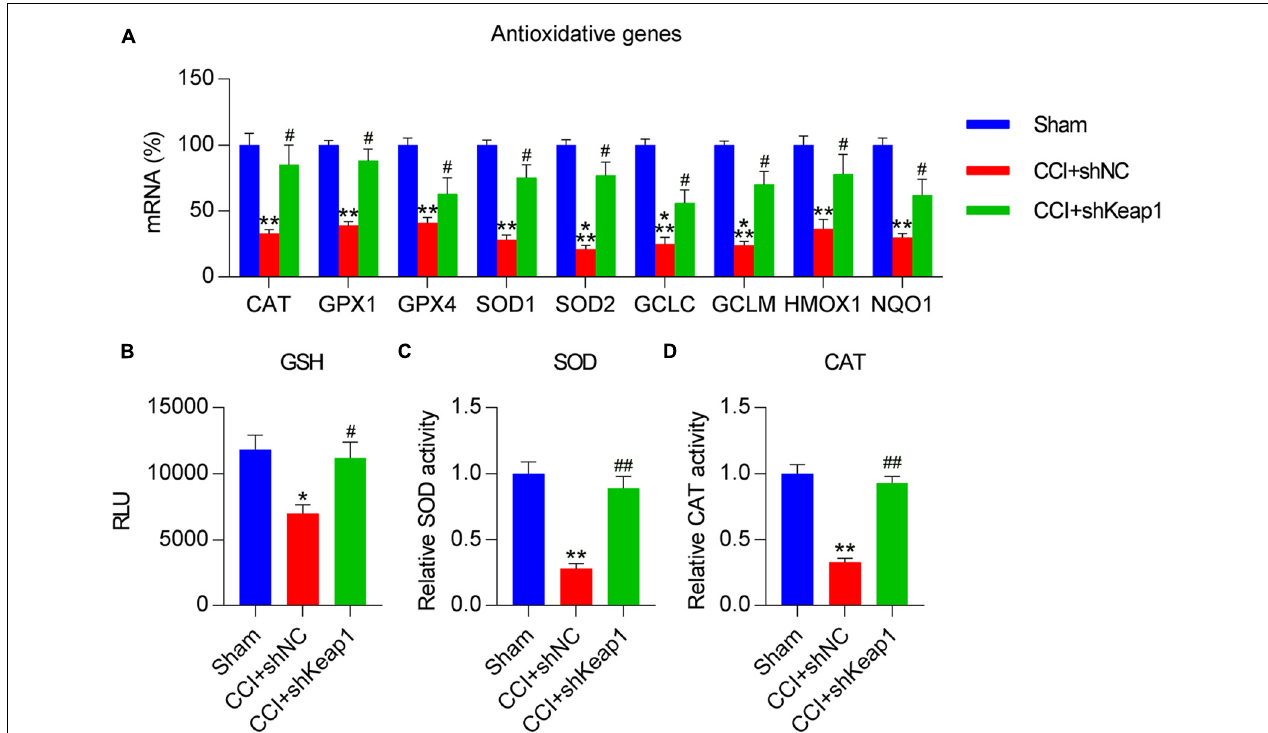
FIGURE 9 | Effect of Keap1 silencing on CCI-repressed antioxidant capacity in spinal cord tissues of rats. Rats were intrathecally injected with lentiviral-shNC or lentiviral-shKeap1 for 1 week and then subjected to CCI surgery. (A) Levels of antioxidant genes in the spinal cord were determined via quantitative polymerase chain reaction. (B) Analysis of glutathione levels. (C) A superoxide dismutase assay kit was used to examine SOD activity. (D) Determination of catalase activity. * P < 0.05, ** P < 0.01 vs. Sham group; # P < 0.05, ## P < 0.01 vs. CCI + shNC group.